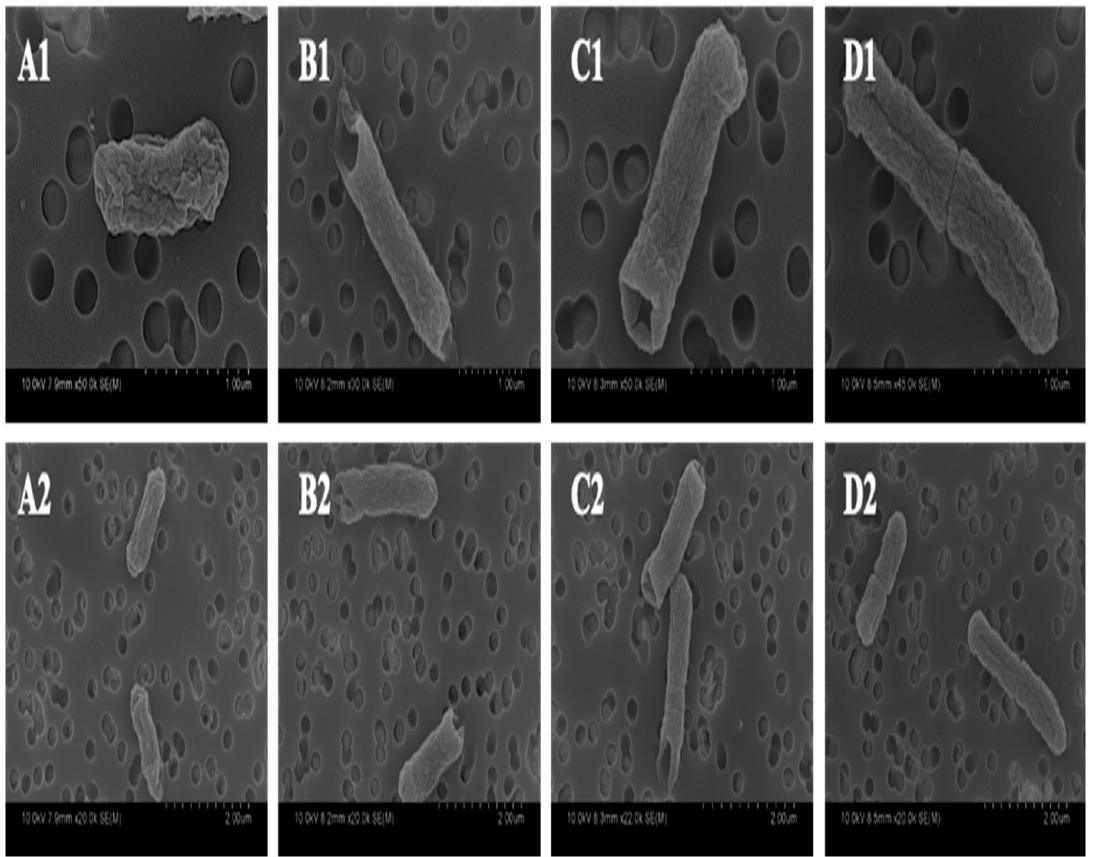
Figure 5. Scanning electron microscopy (SEM) images of untreated ST as negative control ( A1,A2 ), as well as treated ST with GA ( B1,B2 ), PA ( C1,C2 ), VA ( D1,D2 ), taken at 1 μ m ( A1–D1 ) and 2 μ m ( A2–D2 ) magnification.